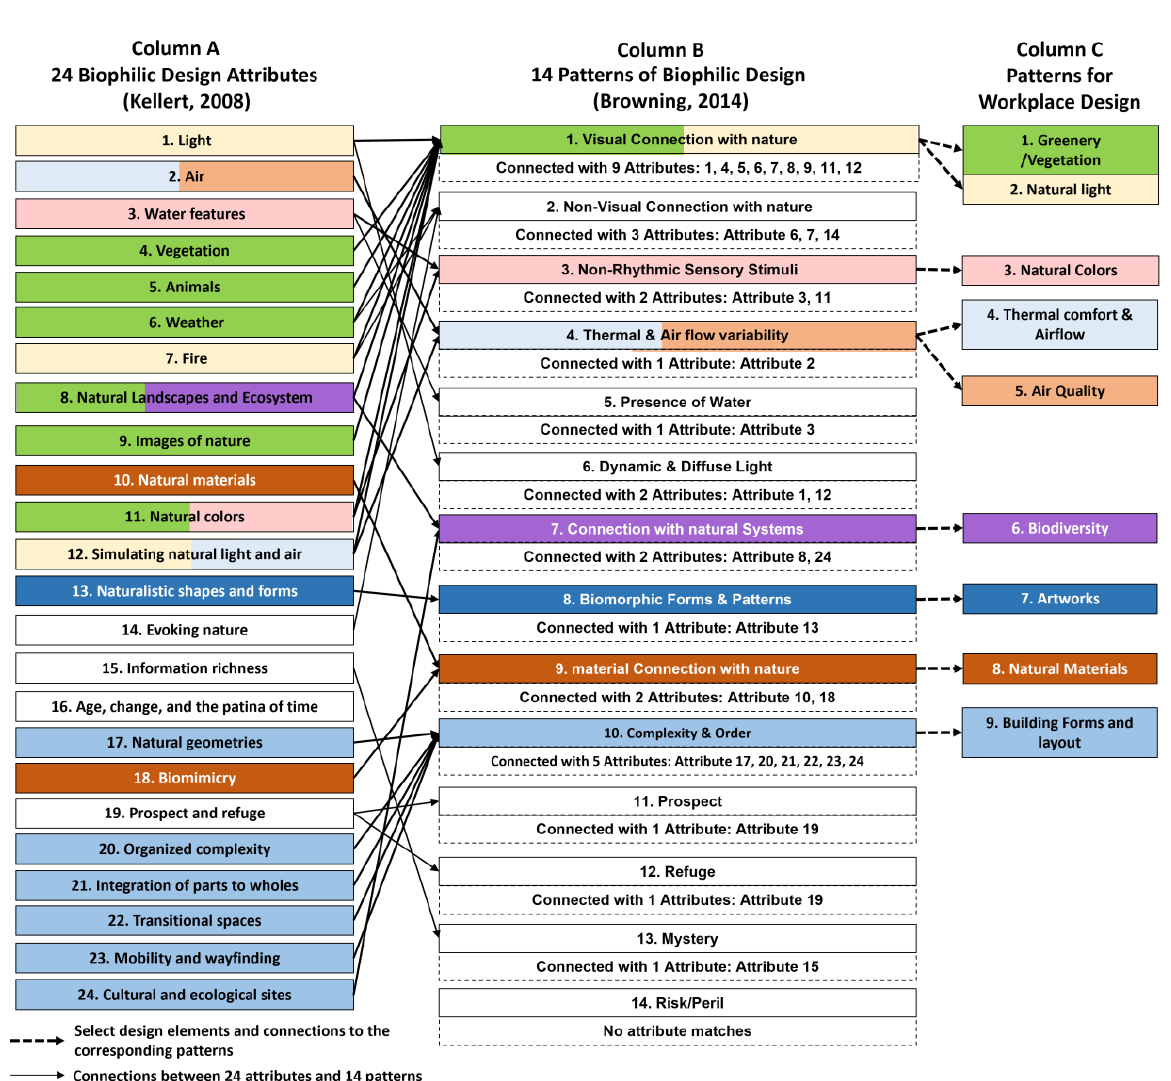
Figure 1. The connections between 24 Biophilic Design Attributes (Column A) and 14 Patterns of Biophilic Design (Column B); the nine biophilic design attributes for the workplace (Column C).